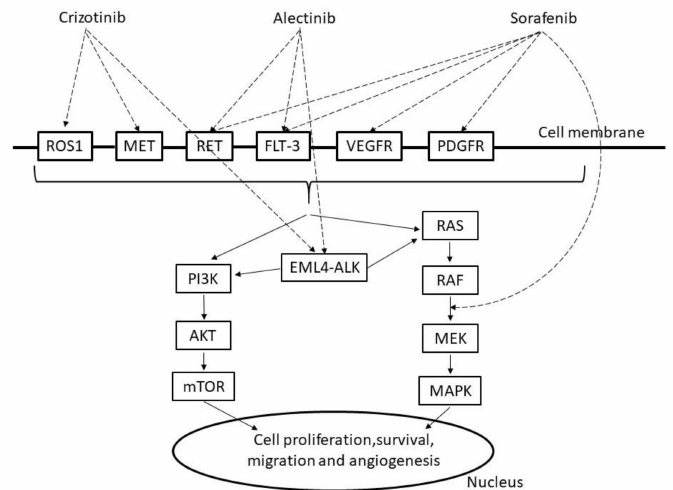
Figure2. Mechanismofcrizotinib, alectinibandsorafenib. ROS1: c-ROSoncogene1, MET:mesenchymal epithelial transition factor, RET: proto-oncogene ret, FLT-3: Fms-like tyrosine protein kinase, VEGFR: vascular endothelial growth factor receptor, PDGFR: platelet-derived growth factor receptors, PI3K: phosphoinositide 3 kinase, AKT: v-act murine thymoma viral oncogene homolog, mTOR: mammalian target of rapamycin, EML4-ALK: echinoderm microtubule associated protein like 4, RAS: rat sarcoma protein, RAF: v-raf murine viral oncogene homolog, MAPK: mitogen activated protein kinase, MEK:,MAPK / extracellular signal regulated kinase(ERK)